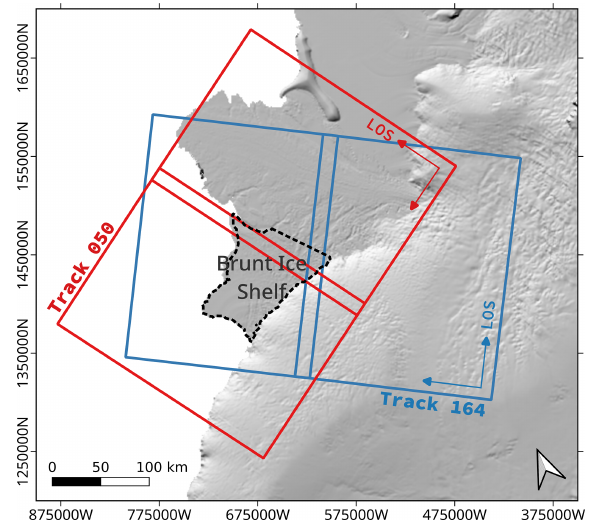
Figure 6. Sentinel-1 coverage of BIS: track 50 (red) and track 164 (blue). The background is a shaded relief of the REMA DEM (Howat et al., 2019). In IW mode, incidence angles vary from about 30 ◦ in the near range to 45 ◦ in the far range.